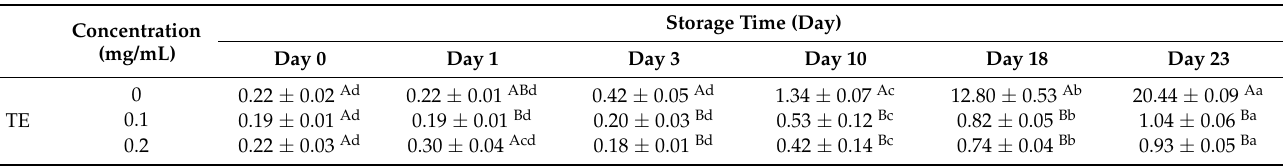
Table 2. The effect of the ethanolic extract and newly identified compounds from the seed coat of Torreya grandis on the content of MDA in the O/W emulsion (TBARS mg/kg sample). Concentration